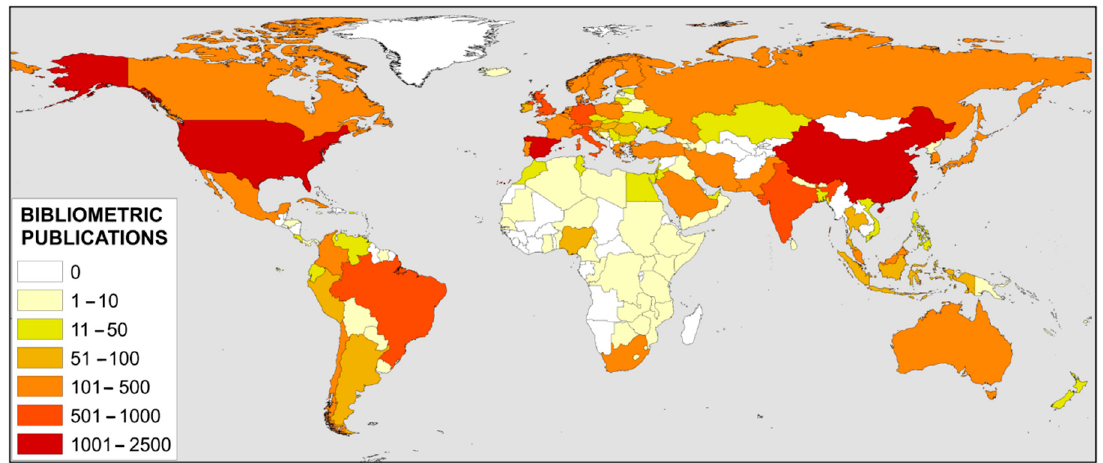
Figure 4. Worldwide distribution by country of scientific production on bibliometrics.